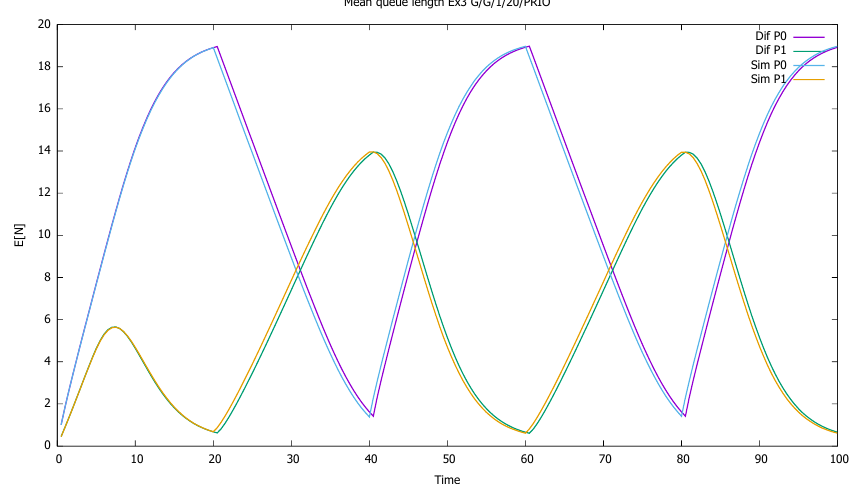
Figure 9. Section 3.3, high load: mean queue lengths of priority (P0) and non-priority (P1)